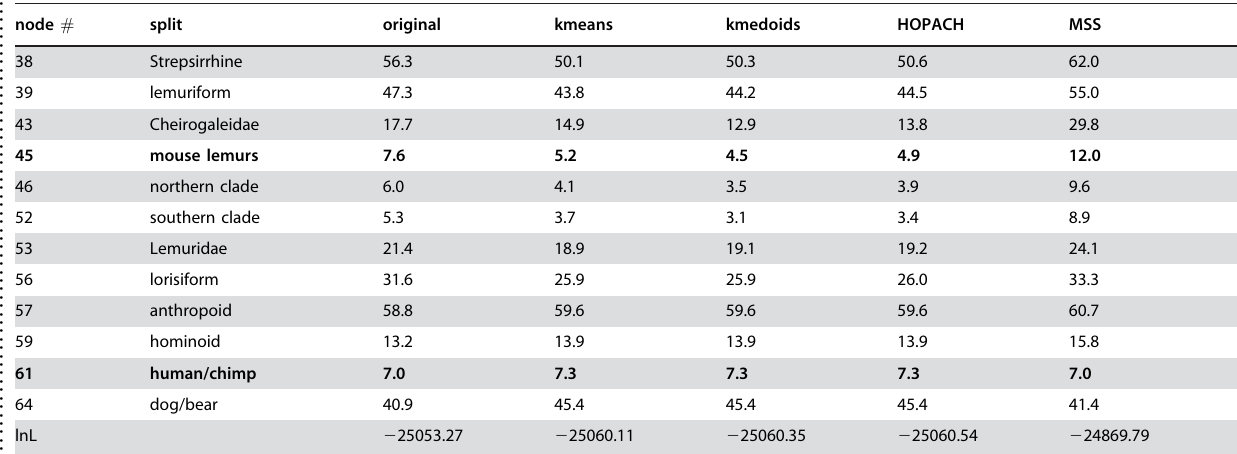
Table 1. Maximum likelihood estimates of divergence times for the mouse lemur data under nucleotide and codon models. .. ... .... ... ... .... ... ... .... ... ... .... ... ... .... ... ... .... ... ... .... ... ... .... ... ... .... ... ... .... ... ... .... ... ... .... ... ... .... ... ... .... ... ... . node